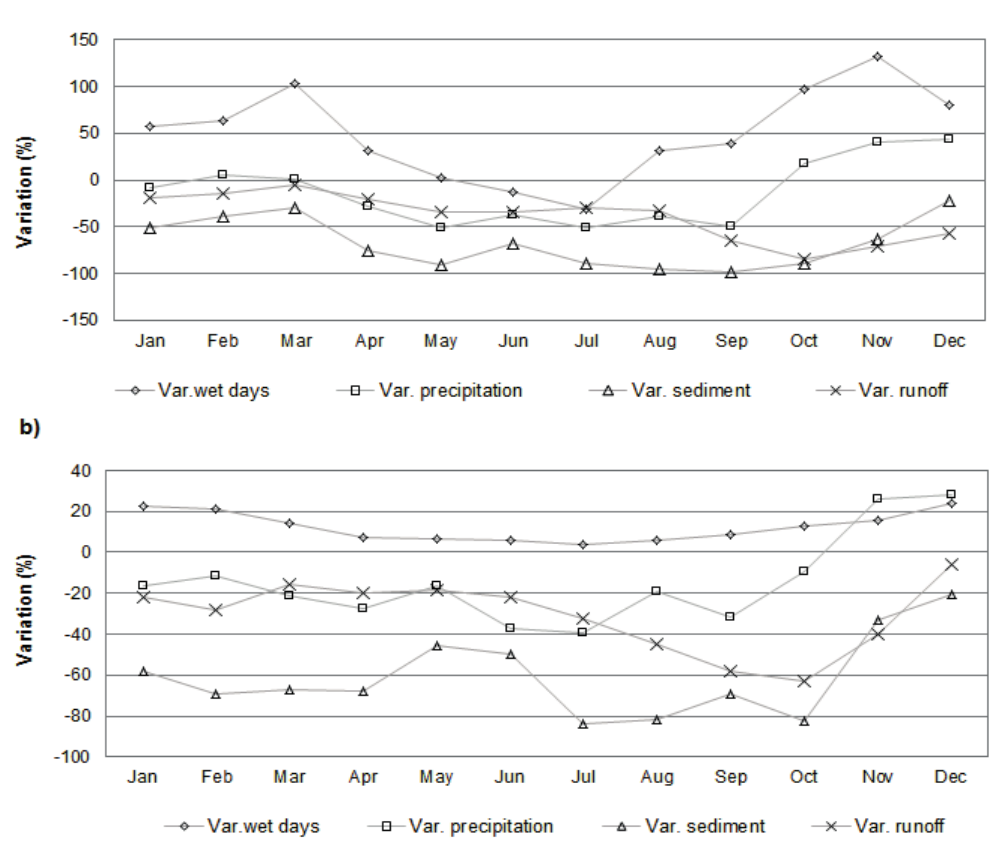
Fig. 4 Var. wet days: variation of wet days (rainfall greater than 1mm per day). Var. precipitation: variation of monthly precipitation. Var. Sediment: monthly variation of sediment yield. Var. Runoff: variation of runoff. (a) A2 Scenario. (b) B2